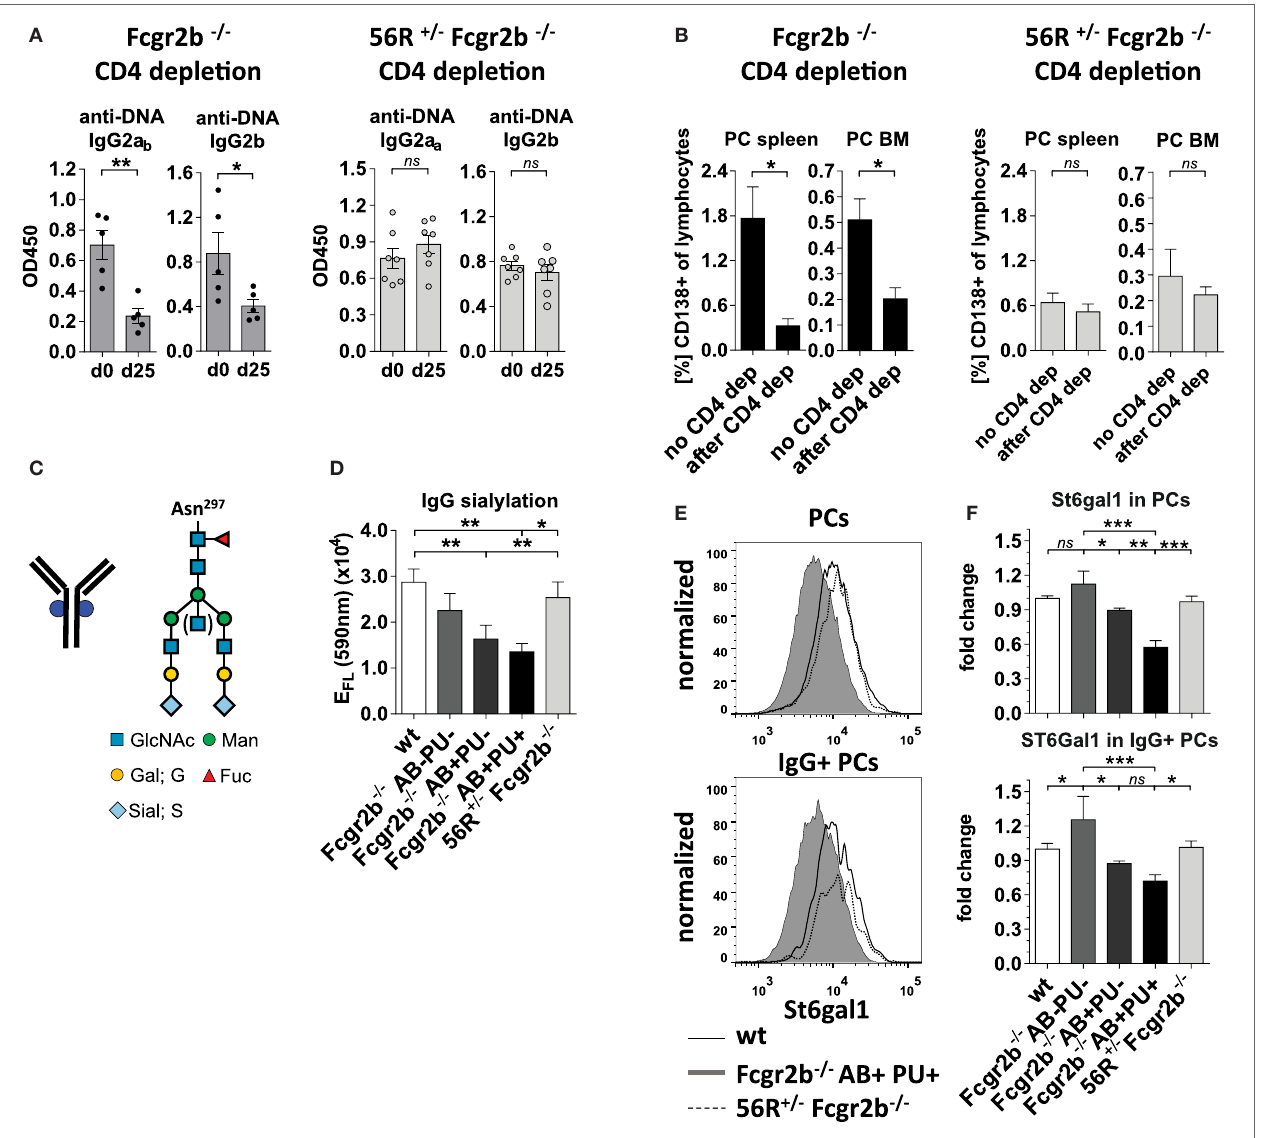
FigUre 3 | Self- and polyreactive IgG2a and IgG2b autoantibodies (autoAbs) in 56R + / − Fcgr2b − / − mice develop T cell independently and are sialylated. (a,B) AutoAb-positive 5-month-old Fcgr2b − / − mice or 2.5-month-old 56R + / − Fcgr2b − / − mice received i.p. injections of anti-mouse CD4 (GK1.5) every 4 days for 25 days to deplete CD4 + T cells (Figure S2 in Supplementary Material). (a) Serum anti-DNA IgG2a b , IgG2b and IgG2a a levels before and after CD4 depletion. (B) The frequencies of CD138 + PCs in the spleen and bone marrow (BM) of untreated ( n = 6) versus CD4-depleted ( n = 4) Fcgr2b − / − mice, and untreated (spleen, n = 13; BM, n = 3) versus CD4 depleted ( n = 4) 56R + / − Fcgr2b − / − mice were analyzed via FACS. One representative experiment is shown. (c) The biantennary core of the glycan structure linked to Asn 297 in the Fc region of IgG Abs consists of four N-acetylglucosamines (GlcNAc; blue) and three mannoses (Man), which can be further modified with fucose, bisecting GlcNAc and terminal galactose (G) and sialic acid (S) residues. (D) The sialic acid content in serum IgG Abs of 5–6-month-old autoAb (AB)-negative and proteinuria (PU)-negative [AB − PU − ( n = 8), AB + PU − ( n = 6) and AB + PU + ( n = 4)] Fcgr2b − / − mice and 56R + / − Fcgr2b − / − mice ( n = 11) compared to wt mice ( n = 10) were analyzed with the GlykoScreen ™ Sialic Acid Quantification Kit (Prozyme) (Efl: fluorescence emission at 590 nm). (e,F) St6gal1 protein expression in splenic total and IgG + PCs of 6–7-month-old AB − PU − ( n = 4), AB + PU − ( n = 5) and AB + PU + ( n = 9) Fcgr2b − / − mice and 56R + / − Fcgr2b − / − mice ( n = 6), compared to wt mice ( n = 5). (e) Representative intracellular staining of St6gal1 protein expression levels in splenic PCs of wt, AB + PU + Fcgr2b − / − and 56R + / − Fcgr2b − / − mice measured by flow cytometry. (F) Relative median fluorescence levels of St6gal1 protein expression. Median St6gal1 protein expression levels in total or IgG + PCs of three independent experiments were measured by flow cytometry and normalized (fold change) to the expression in wt controls ( = 1) in the respective experiments. The normalized data of three independent experiments were summarized (mean) in the